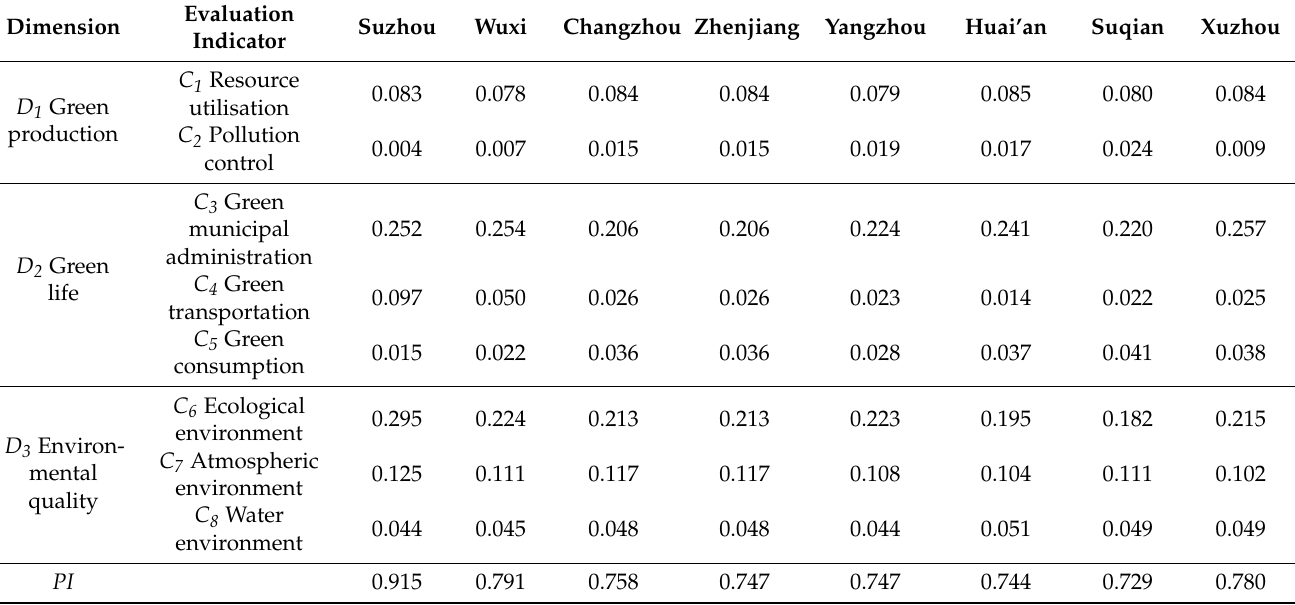
Table 12. Results of evaluation for